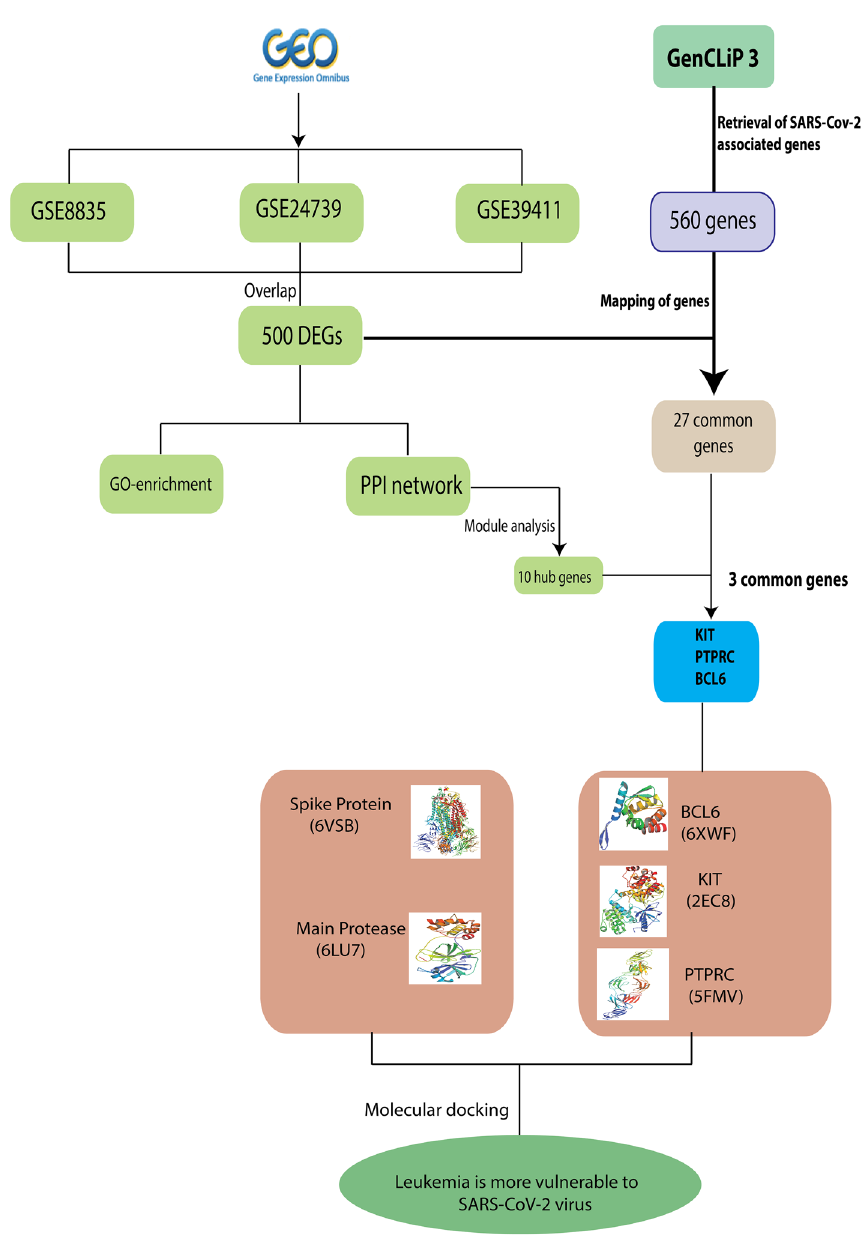
Fig. 1 Schematic workflow